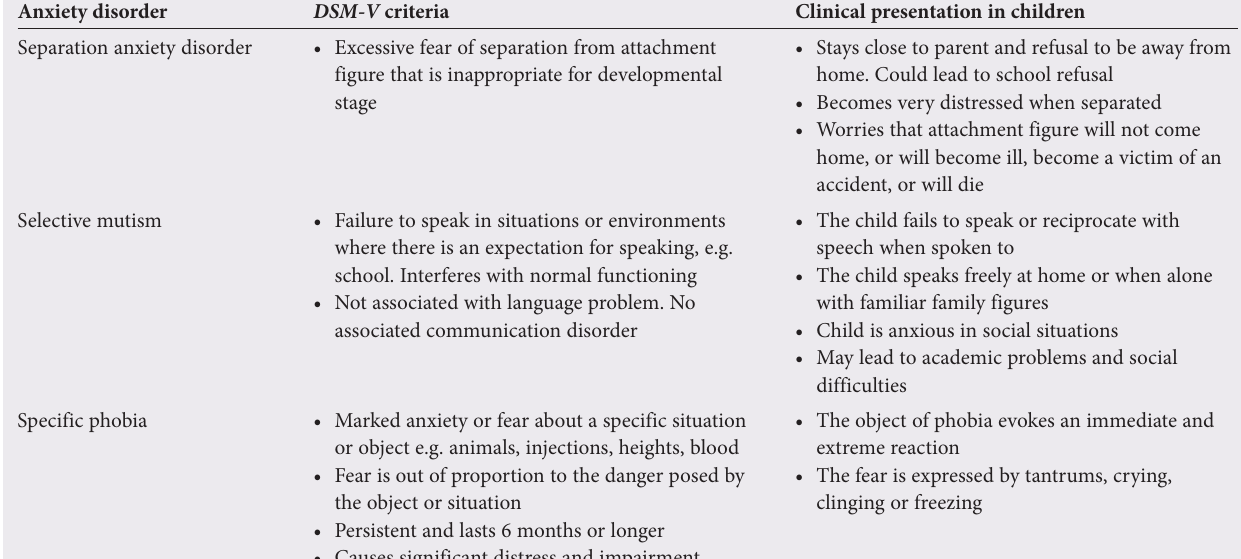
Table 6. Overview of anxiety disorders in children and adolescents Anxiety